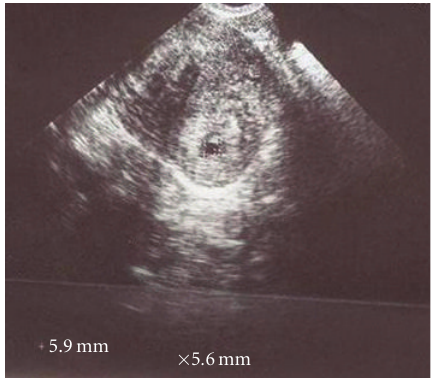
Figure 2: 14 × 10mm cornual gestational sac despite two systemic and one local MTX injection.